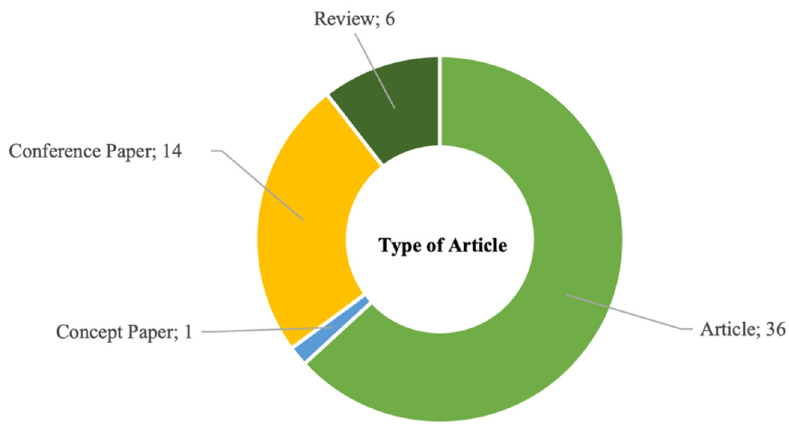
Figure 3. Type of Figure 3. Type of articles.